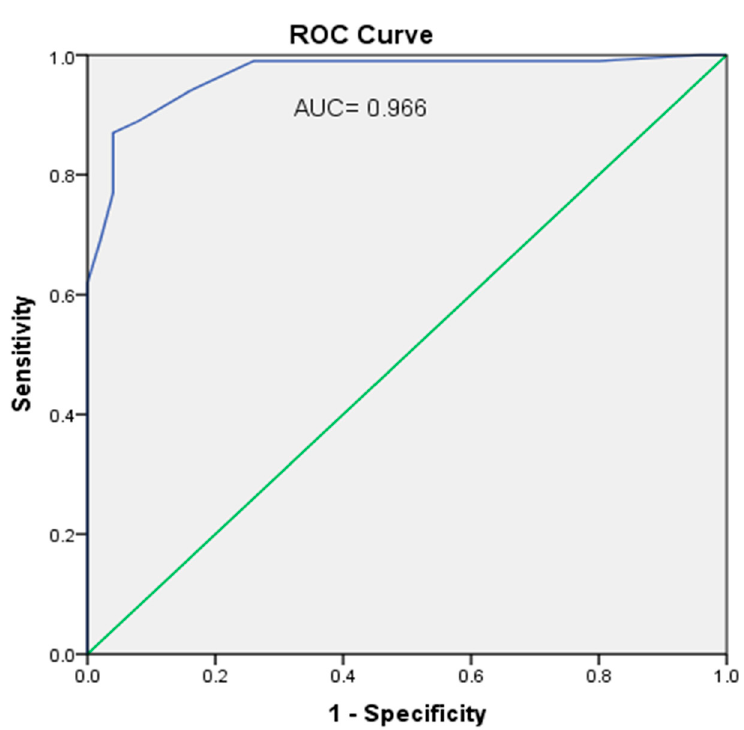
Figure 5. ROC curve shows area under the curve (AUC = 0.966). The optimal cut-off point for relative FOXO1 gene expression was 1.35 with a sensitivity of 94%, specificity of 84% and Youden index = 177.